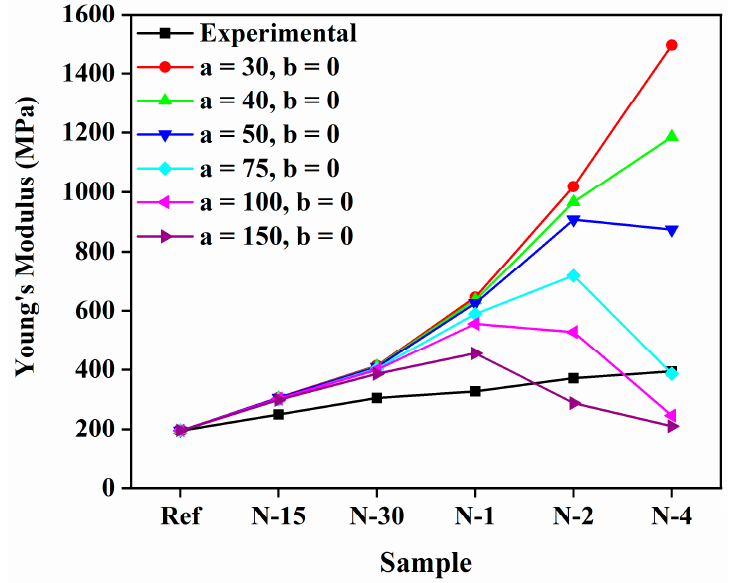
Figure 5. Effect of the aggregation/agglomeration coefficients a on E c of the nylon 6 nanofiber-reinforced PUA composites.